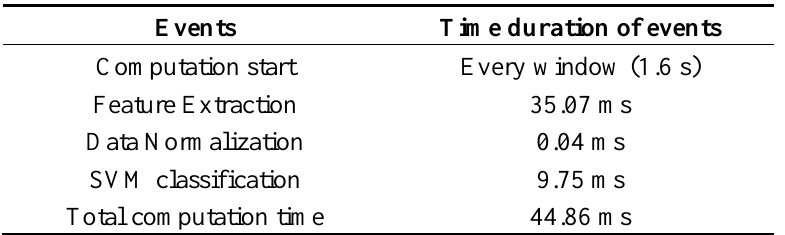
Table 4. MCU’s computation